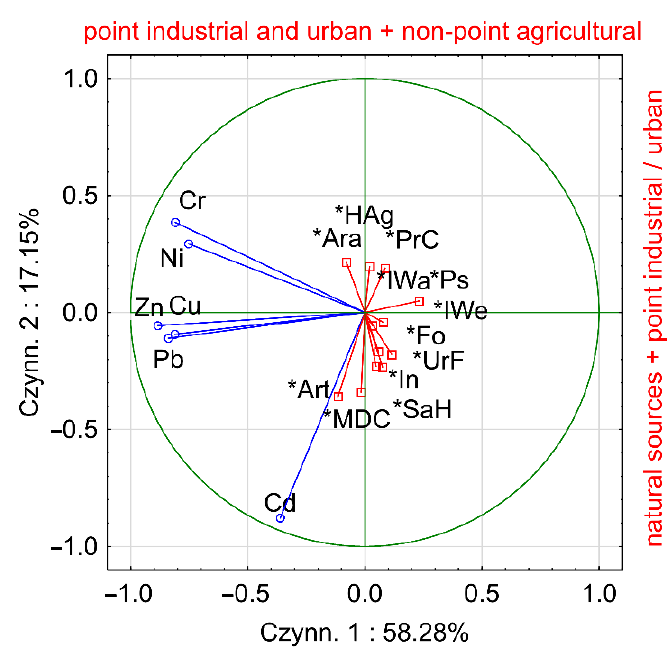
Figure 9. PCA results.